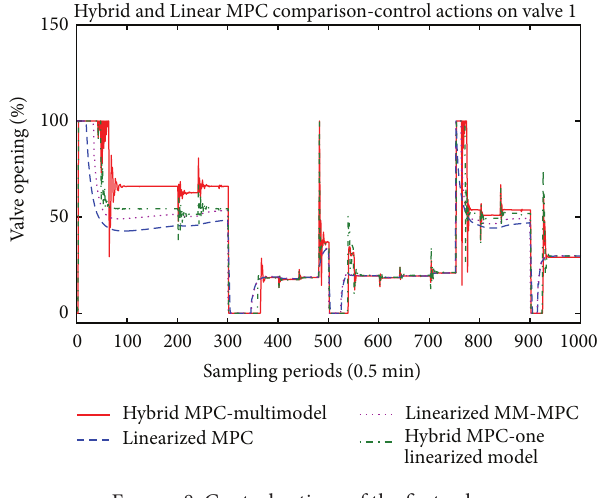
Figure 8: Control actions of the first valve.